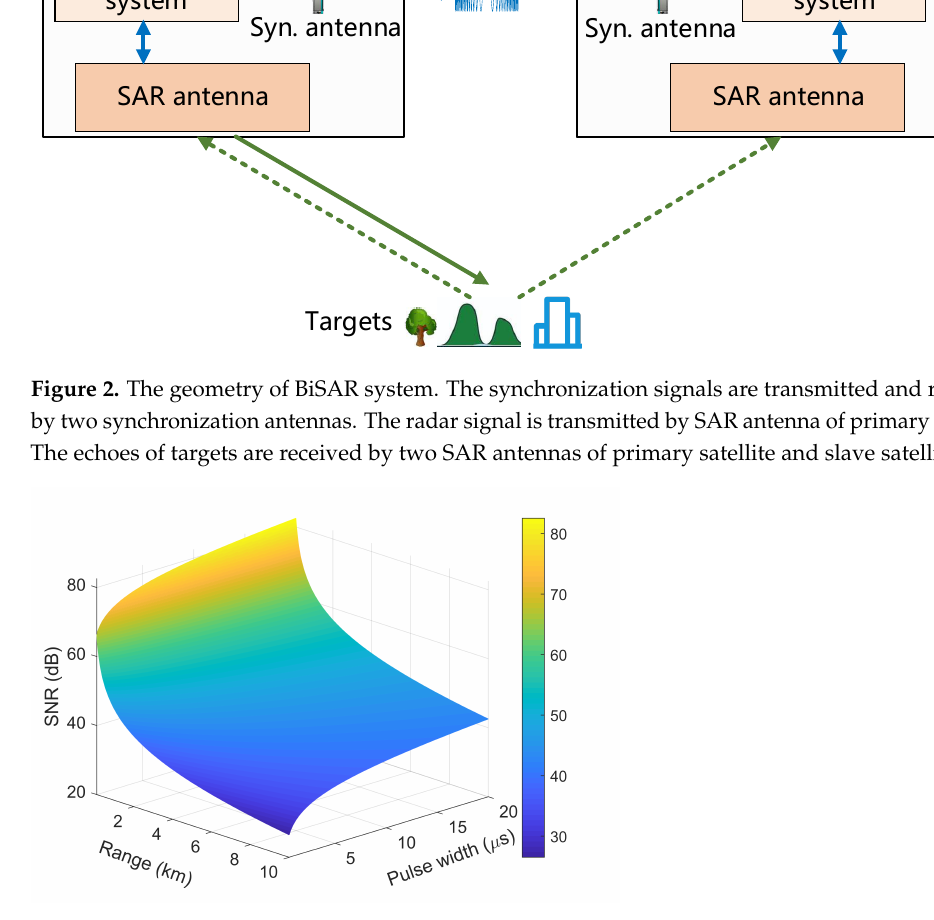
Figure 3. The SNR varies with distance and pulse width under the condition of P t = 1